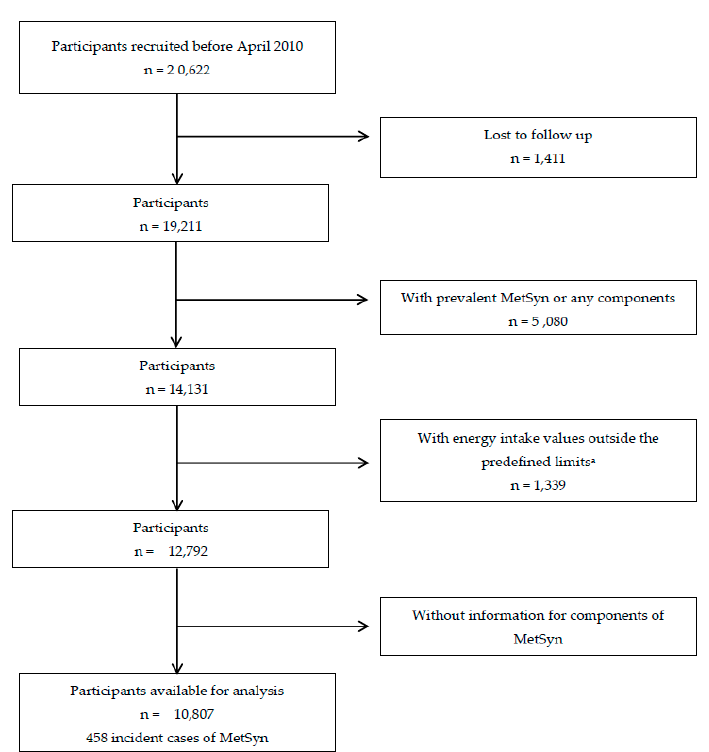
Figure 1. Flow chart depicting the selection process among participants of the Seguimiento Universidad de Navarra (SUN) cohort, 1999–2017; n : Number of participants; MetSyn: Metabolic Syndrome. a Total energy intake outside predefined limits (<800 or >4000 kcal/day for men, and<500 or >3500 kcal/day for women) [21].